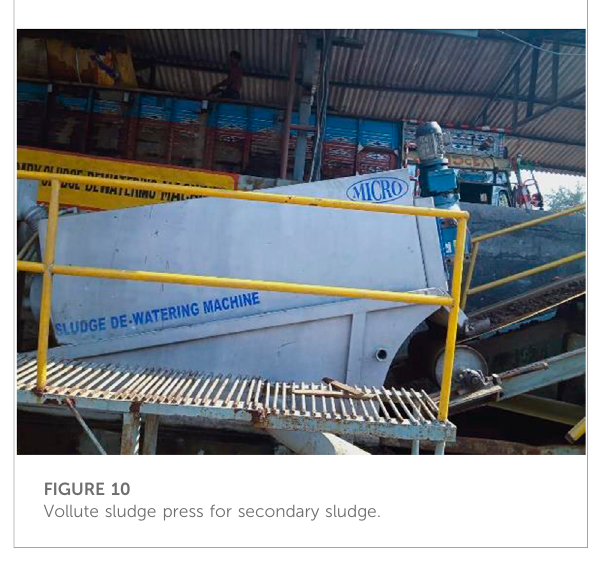
FIGURE 10 Vollute sludge press for secondary sludge.